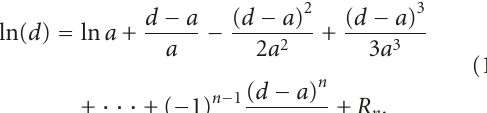
curves: Figure 10 for a flat open square and Figure 11 for